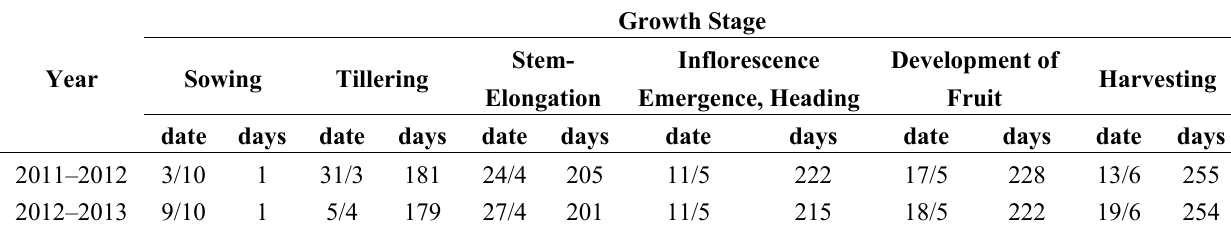
Table 2. Data and days after sowing of different growth stages for winter wheat during the experiment in 2012 and